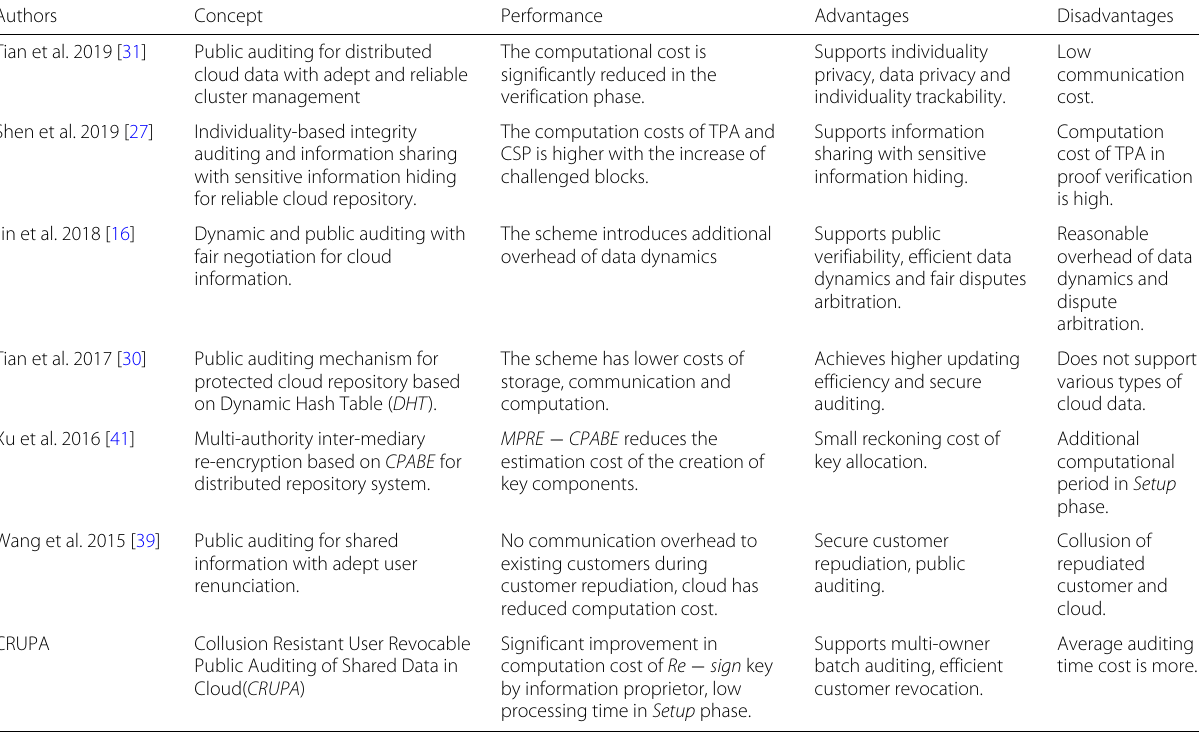
Table 1 Comparison of mechanisms for Public Honesty Verification with group customer repudiation